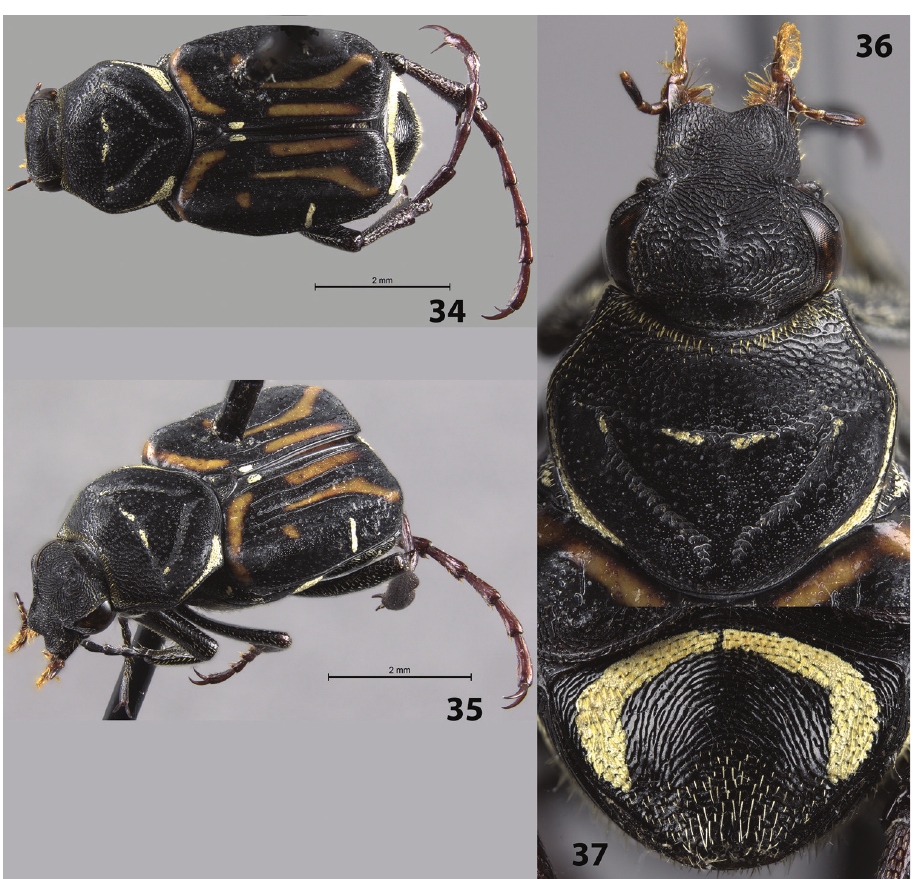
Figures 34–37. Trigonopeltastes mombachoensis sp. n., female allotype. 34 Dorsal view of habitus 35 Oblique view of habitus 36 Head and pronotum 37 Pygidium. oblique, cretaceous markings on each side. Elytra: Surface glabrous, matt with shiny micropunctures. Transverse cretaceous band (1 on each side) short, located on basal half of elytral suture. Cretaceous bands (1 on each side) adjacent to lateral edge ap- proximately halfway between base and apex, length approximately ¼ width of elytron (Figs 28–29). Elytral striae 1–4 weakly impressed; remaining striae weakly defined with rows of punctures, not impressed into surface. Orange markings consisting of transverse, basal band; sub-basal, medial spot; 2 longitudinal, medioapical lines (Figs 28–29). Pygidium: Surface with thick, lateral bands of cretaceous makings that are nar- rowly joined basally; non-cretaceous area of disc setose, especially near apex (Fig. 32). Disc with distinct, concentric microridges; surface evenly convex with apex slightly de- flexed. Venter: Metasternum entirely covered with cretaceous markings and light setae, abdominal sternites with broad, medial cretaceous markings and light setae (Fig. 30). Legs: Protibia with 2 teeth near apex, 1 broad medial tooth (Fig. 29). Mesotibia